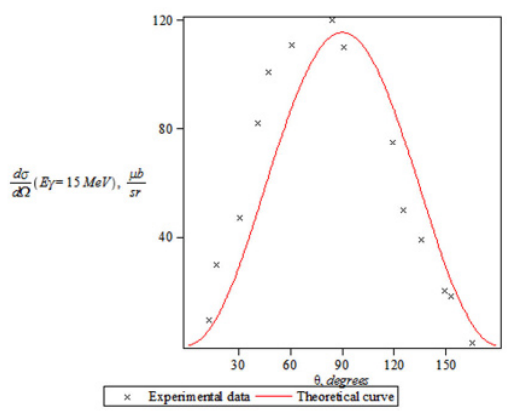
Figure 2. Differential cross section of angel θ